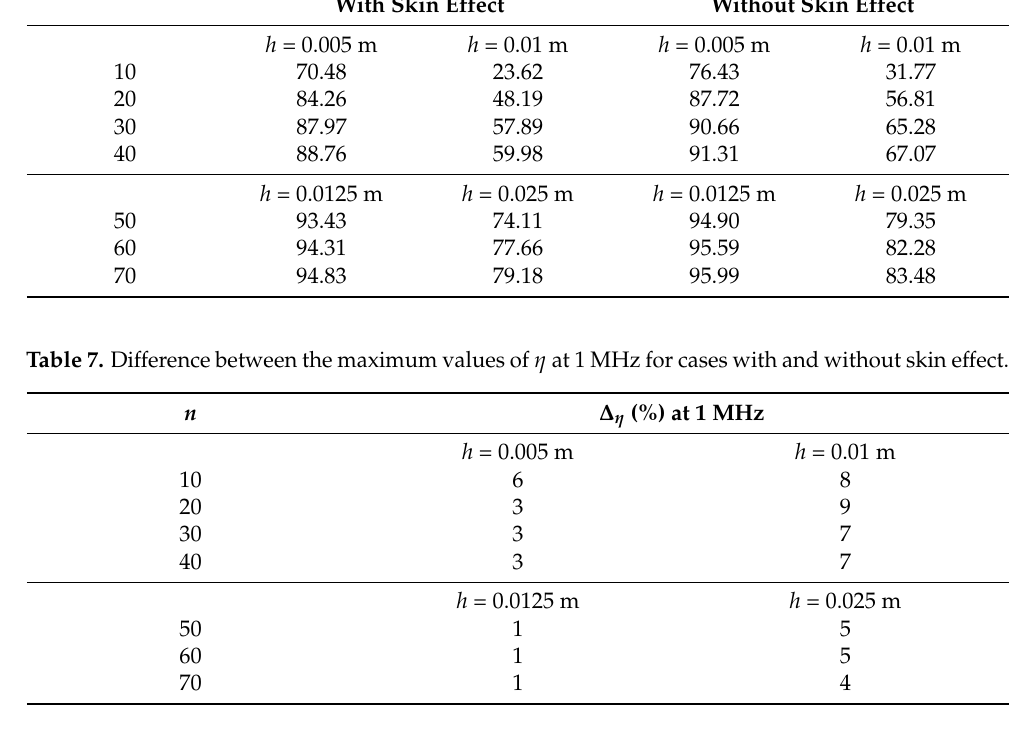
The P t , P r power, and η characteristics are shown on the graphs: in Section 3.2.1 for the small coil and in Section 3.2.2 for the large coil. The numerical analysis results are presented as dashed lines for the case with the skin effect and solid lines for the case without the skin effect (marked as FEM in the legend). The results of the analytical analysis are represented by dots (marked as A in the legend).